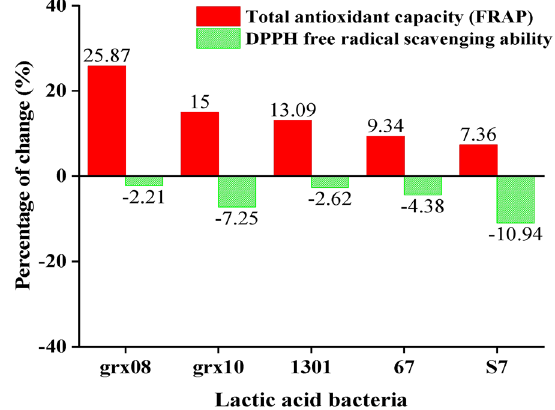
Fig. 4 Percentage change of antioxidant properties of FH06 after 72 h fermentation compared with before fermentation